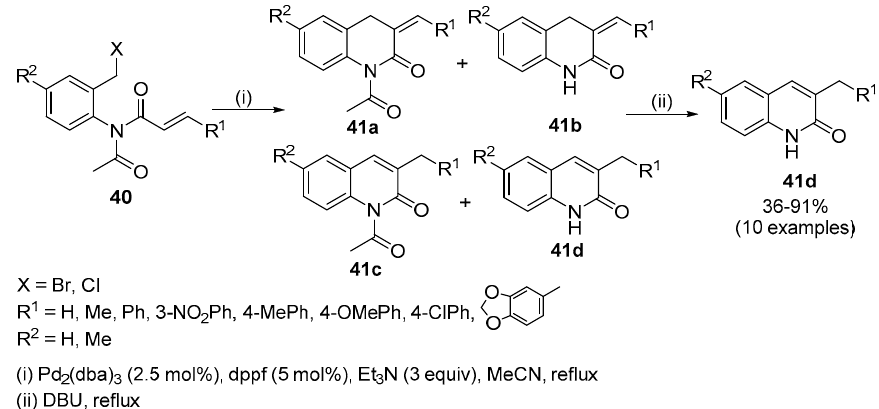
Scheme 13. Synthesis of quinolin-2(1 H )-ones 41d by intramolecular Heck cyclization of acrylamides 40